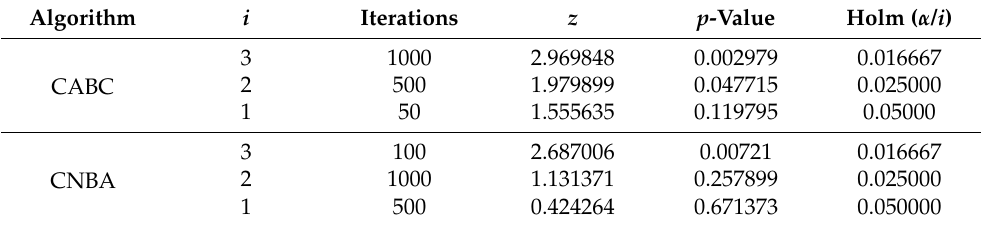
Table 3. Results of the Holm test comparing the best performed iteration number of each algorithm with respect other iteration number, according to ARI